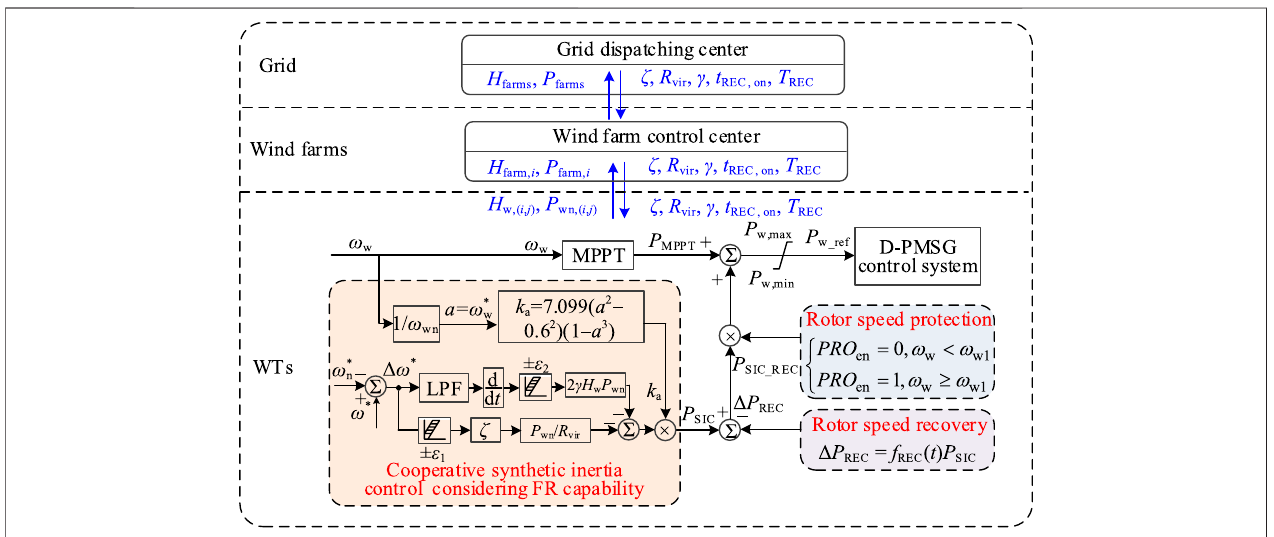
FIGURE 6 | Realization of CSIC considering FR